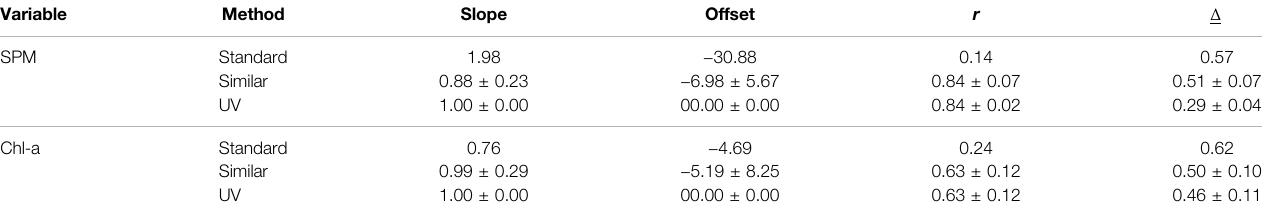
TABLE6| ValidationofS3-OLCIsatellitederivations.Similar( μ ± σ )isobtainedfromsetsofindependentrecordsofsimilarmeasurements.UVisobtainedaftertheapplication of unbiased validation.